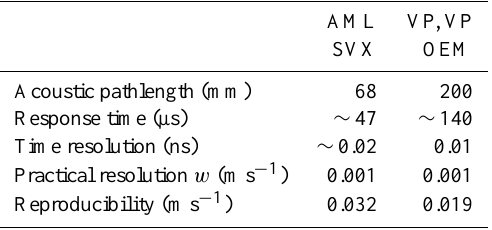
Table 1. Sensor specifications. The response times reflect the time of flight of sound pulses. The reproducibility corresponds to the standard uncertainty for measurements in pure water in our exper- imental setup over a period of 1 (AML) and 2 years (VP), respec- tively (von Rohden et al.,